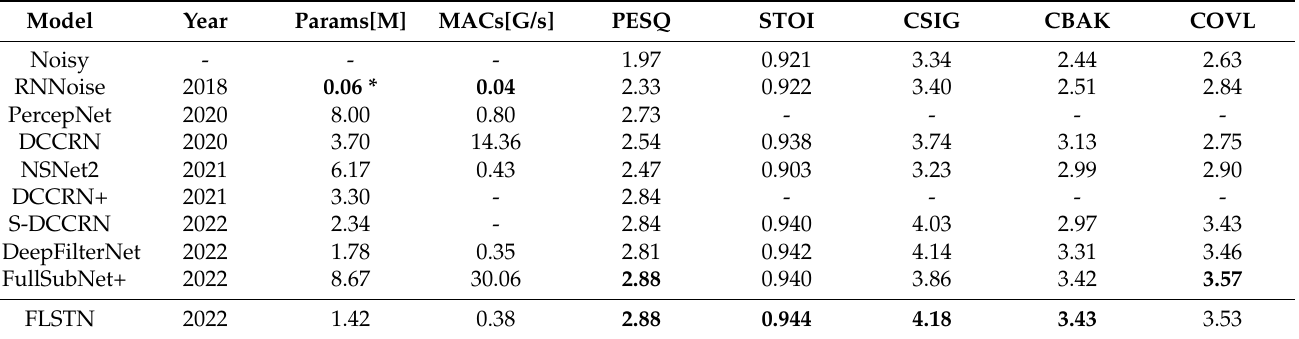
Table 2. Experimental results on VoiceBank-DEMAND test